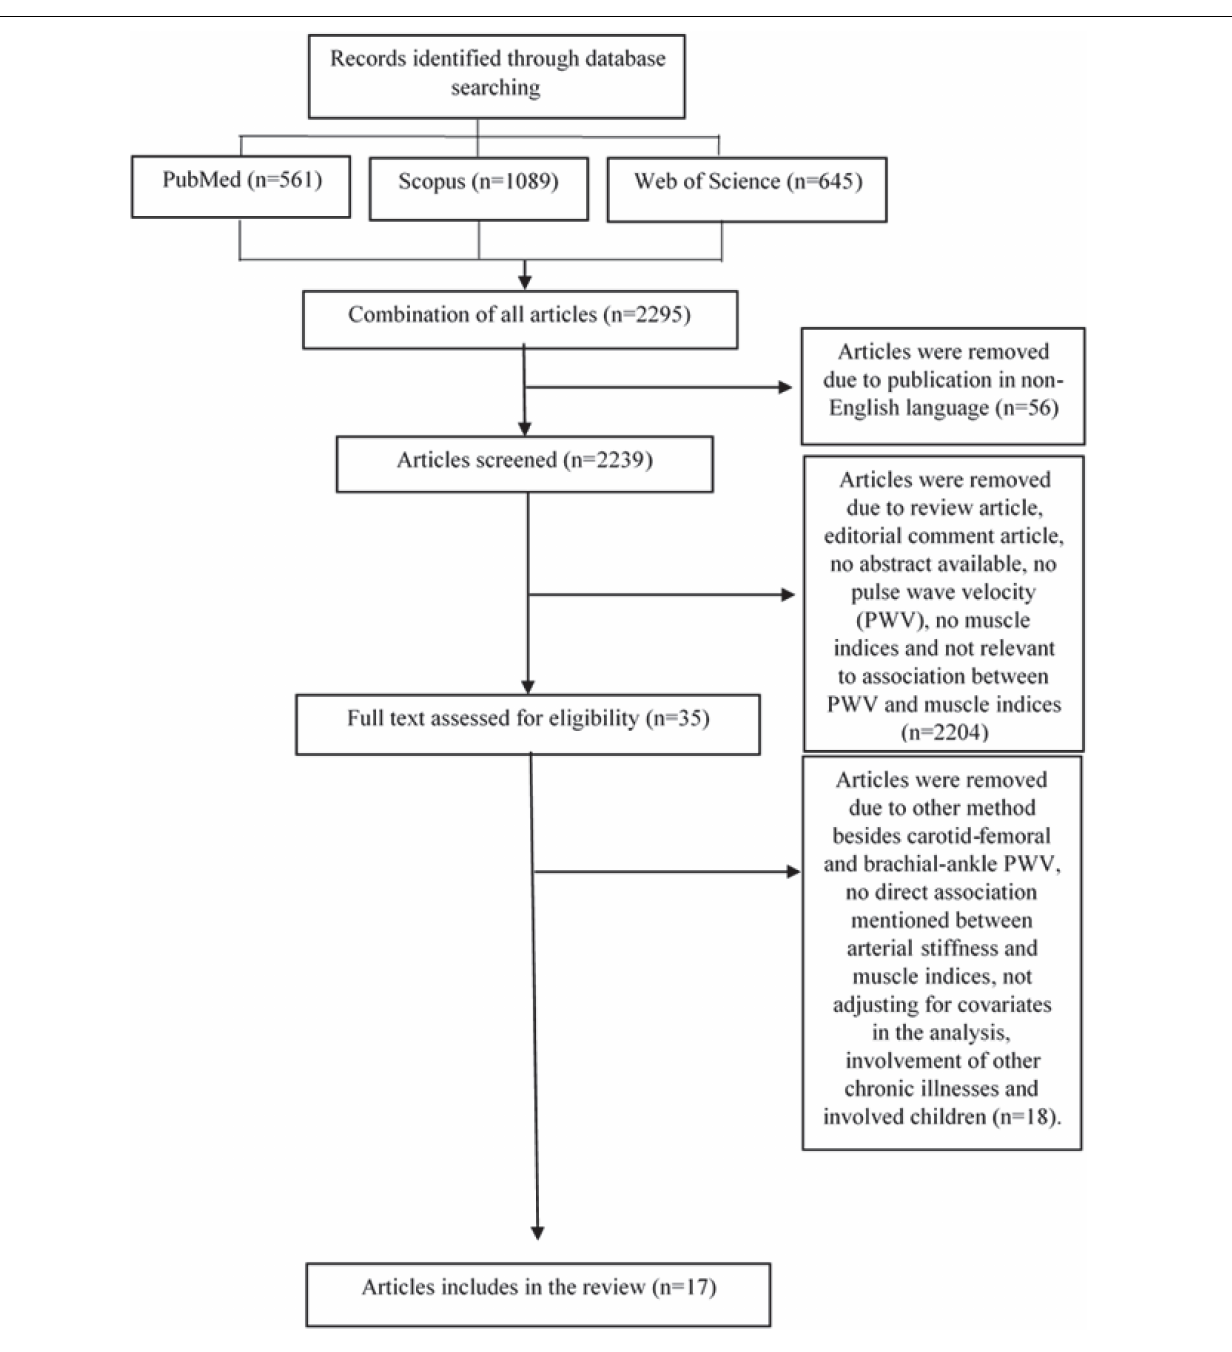
FIGURE 1 | Flowchart of selection of the related